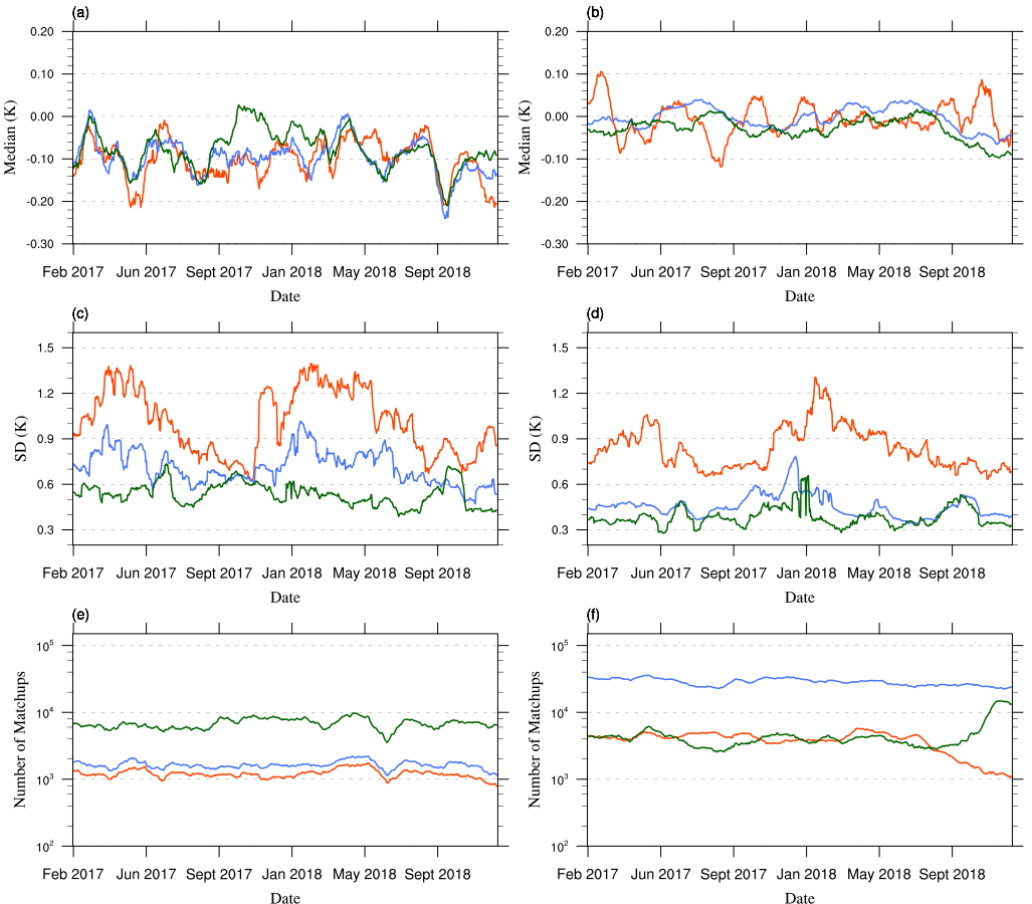
Figure 6. Bias-corrected fv02 L3S-1day, night only, monthly statistics, February 2017 to December 2018, median for ( a ) AVHRR-only and ( b ) Multi-sensor, and standard deviation for ( c ) AVHRR-only and ( d ) Multi-sensor, number of matchups for ( e ) AVHRR-only and ( f ) Multi-sensor, when compared with drifting and tropical moored buoys. Note: Matchup thresholds: < 10 km distance and < 6 h time difference. Statistics relating to QL 5 L3S data are shown in green, QL 4 in blue and QL 3 in orange. Data were obtained from